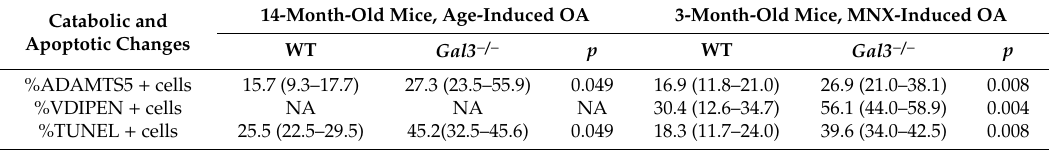
Table 1. Chondrocyte catabolism and apoptosis during age-induced and meniscectomy (MNX)-induced OA.